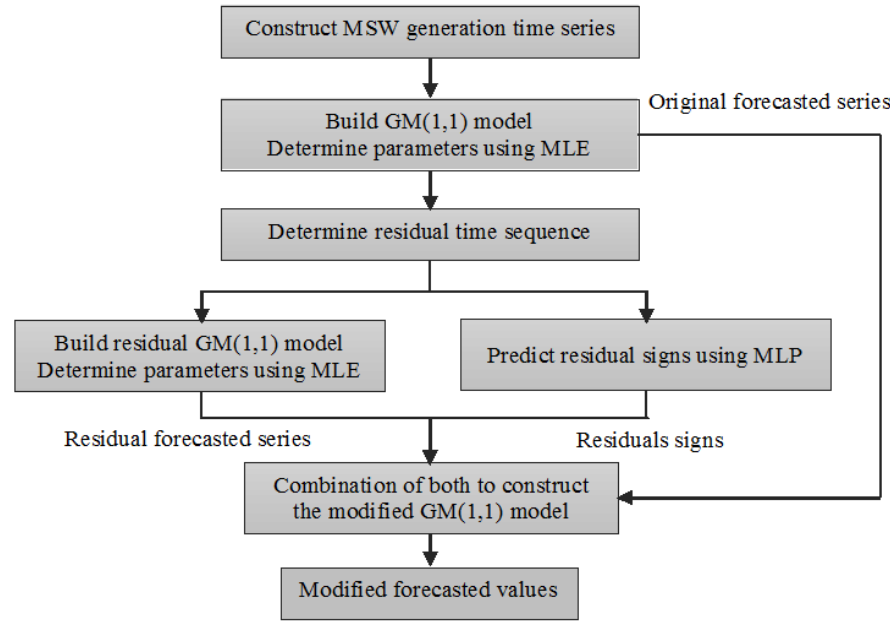
Figure 1. The procedure of developing a modified grey